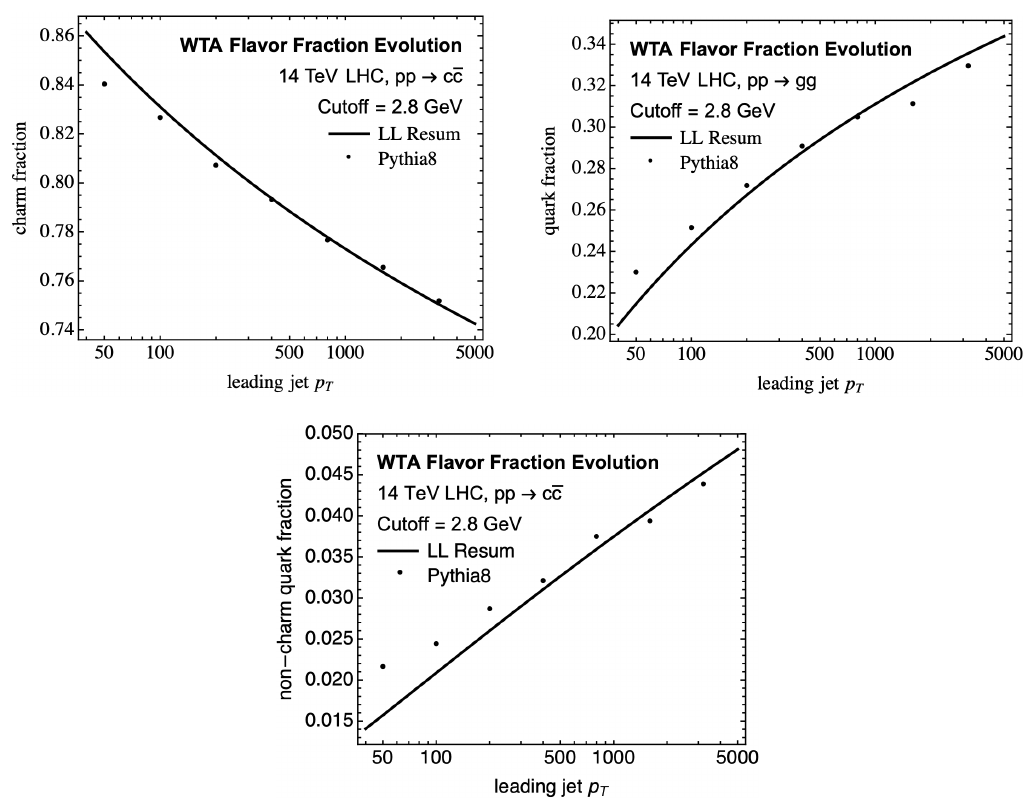
Figure 3 . Comparison of fraction of WTA quark flavor jets from initial high- p ⊥ jets in simulation (dots) and leading-logarithmic analytic evolution (solid). Top left: the flavor fraction of WTA charm flavor jets from initiating charm partons. Top right: the total flavor fraction of WTA quark flavor jets from initiating gluons. Bottom: the flavor fraction of WTA non-charm quark flavor jets from initiating charm